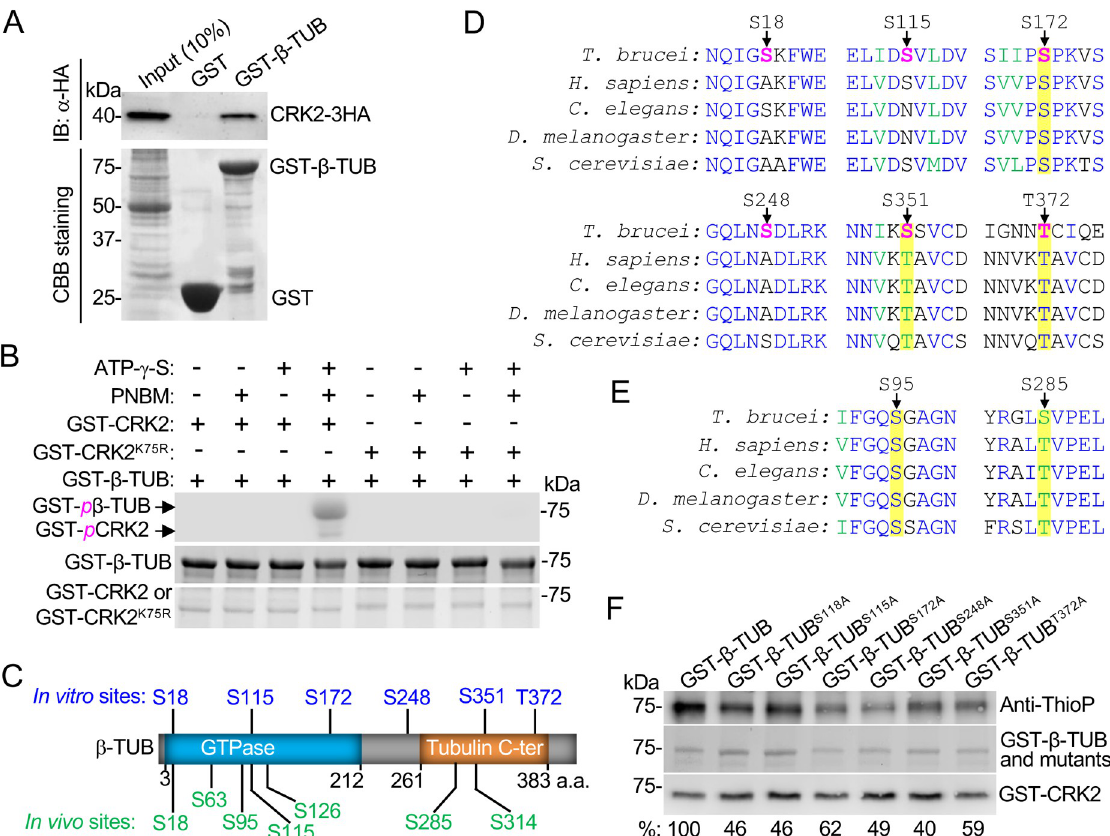
Fig 5. Identification of β -tubulin as an in vitro substrate of CRK2. ( A ). Interaction of β -tubulin with CRK2 examined by GST pull-down. CBB, Coomassie brilliant blue. ( B ). CRK2 phosphorylates β -tubulin in vitro . Shown is the in vitro kinase assay using purified